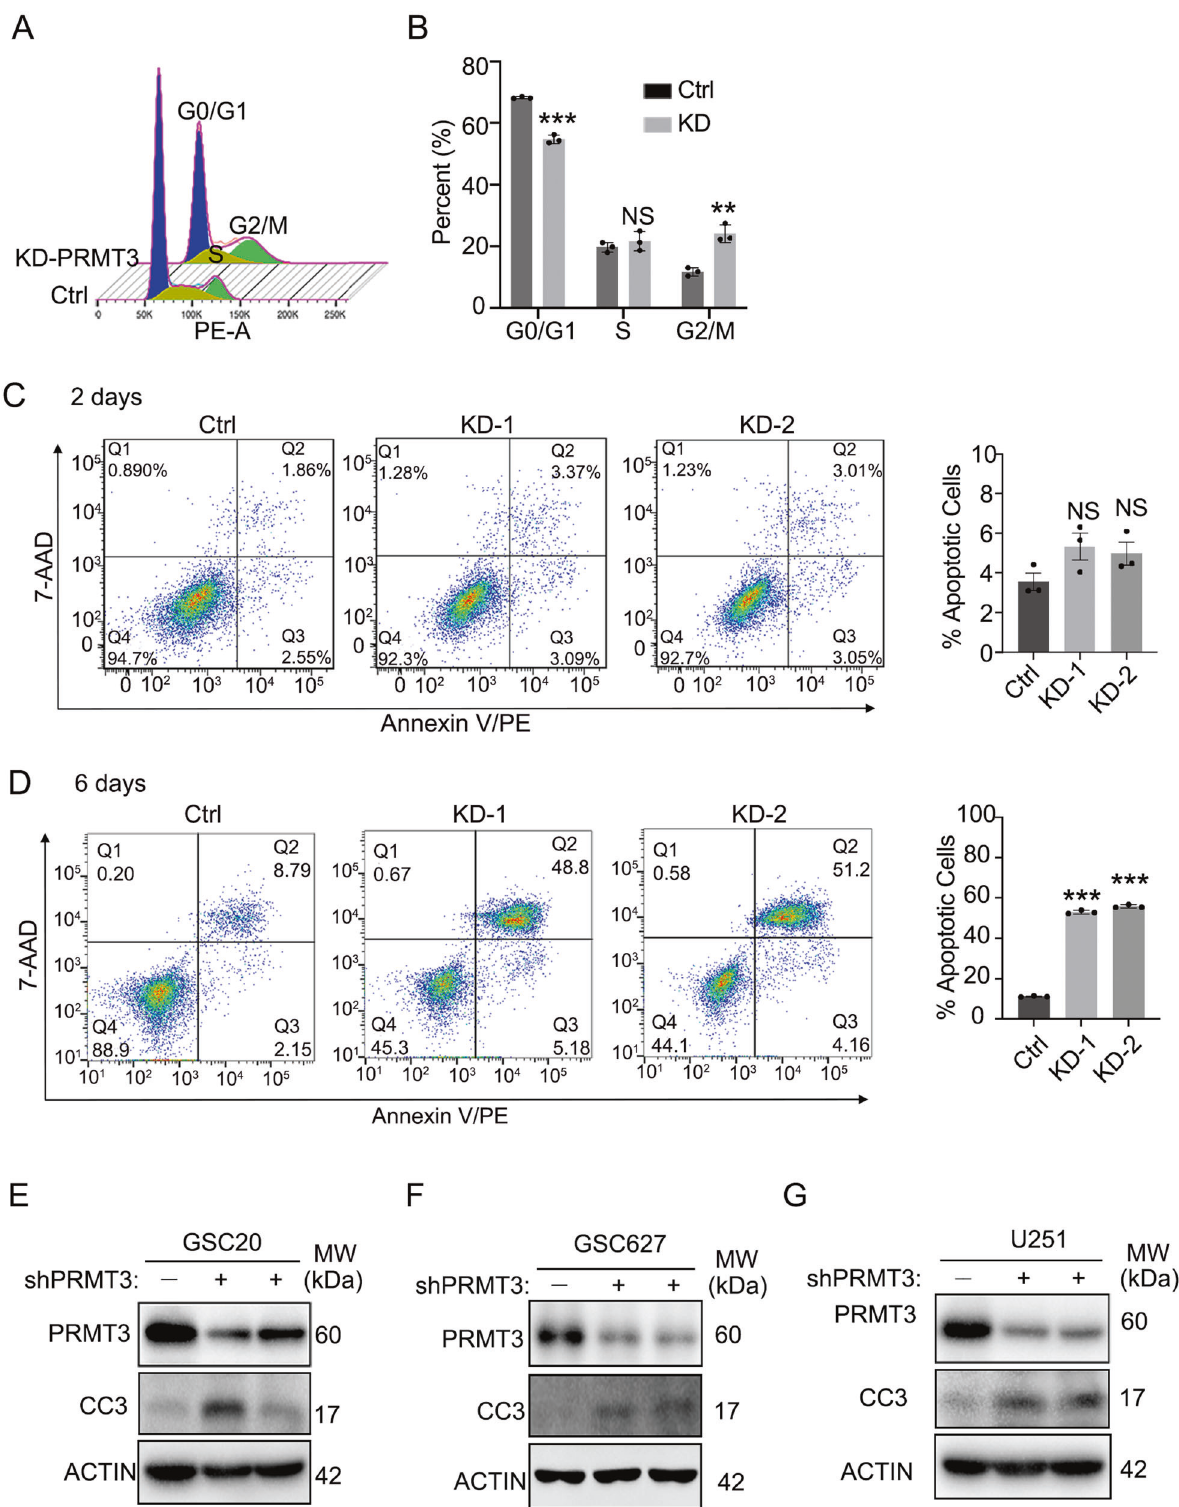
Fig. 3 PRMT3 de fi ciency induces cell cycle arrest and cell death. A , B Flow cytometry cell cycle analysis ( A ) and quanti fi cation ( B ) of shCtrl and shPRMT3-1 (PRMT3 KD) GSC20 cell cultures. Cells were transduced with control or shPRMT3-1 lenti-virus after 48 h. C , D Representative fl ow cytometry analysis of cell apoptosis (left) and quanti fi cation (right). Cells were transduced with control or shPRMT3 lenti-virus after 2 days ( C ) or 6 days ( D ). E-G Representative western blots for cleaved-caspase 3 (CC3) and PRMT3 in GSC20 ( E ), GSC627 ( F ) and U251 ( G ) transduced with lenti-shCtrl and lenti-shPRMT3 for 3 days. ACTIN served as a loading control. Data are presented as means ± SEM; n = 3 independent experiments; ** p < 0.01; *** p < 0.001; two-tailed unpaired Student t-test (in B ) or one-way ANOVA with multiple comparison test (in C , D ). N.S., not signi fi cant.